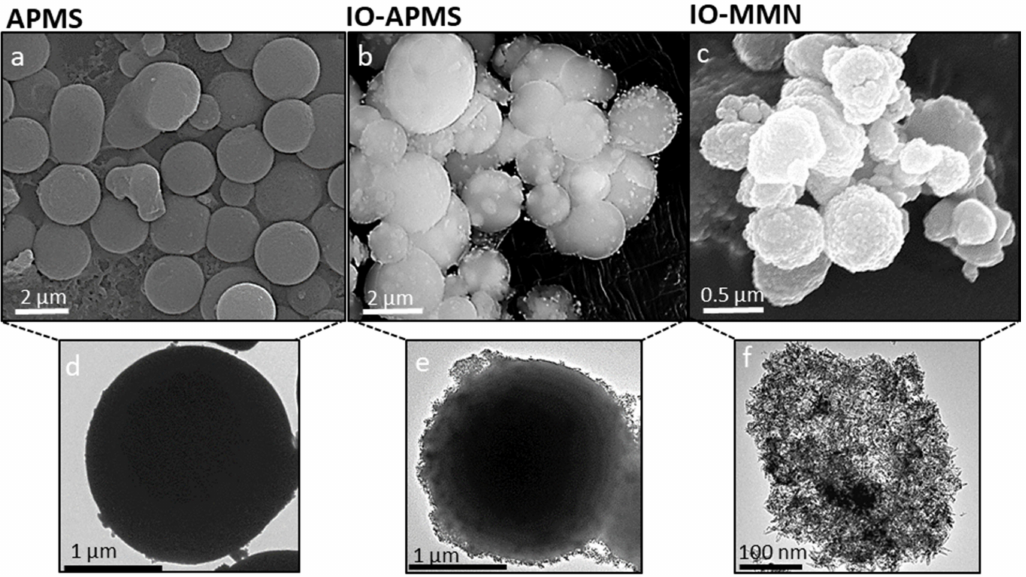
Figure 2. Scanning and transmission electron microscopy images. SEM images of ( a ) APMS silica template, ( b ) iron impregnated APMS (IO-APMS), and ( c ) IO-MMN replicated structures. Respective TEM images of ( d ) APMS, ( e ) IO-APMS, and ( f ) IO-MMN. The electron microscopy images remarkably show the successful formation of iron oxide mesostructures.